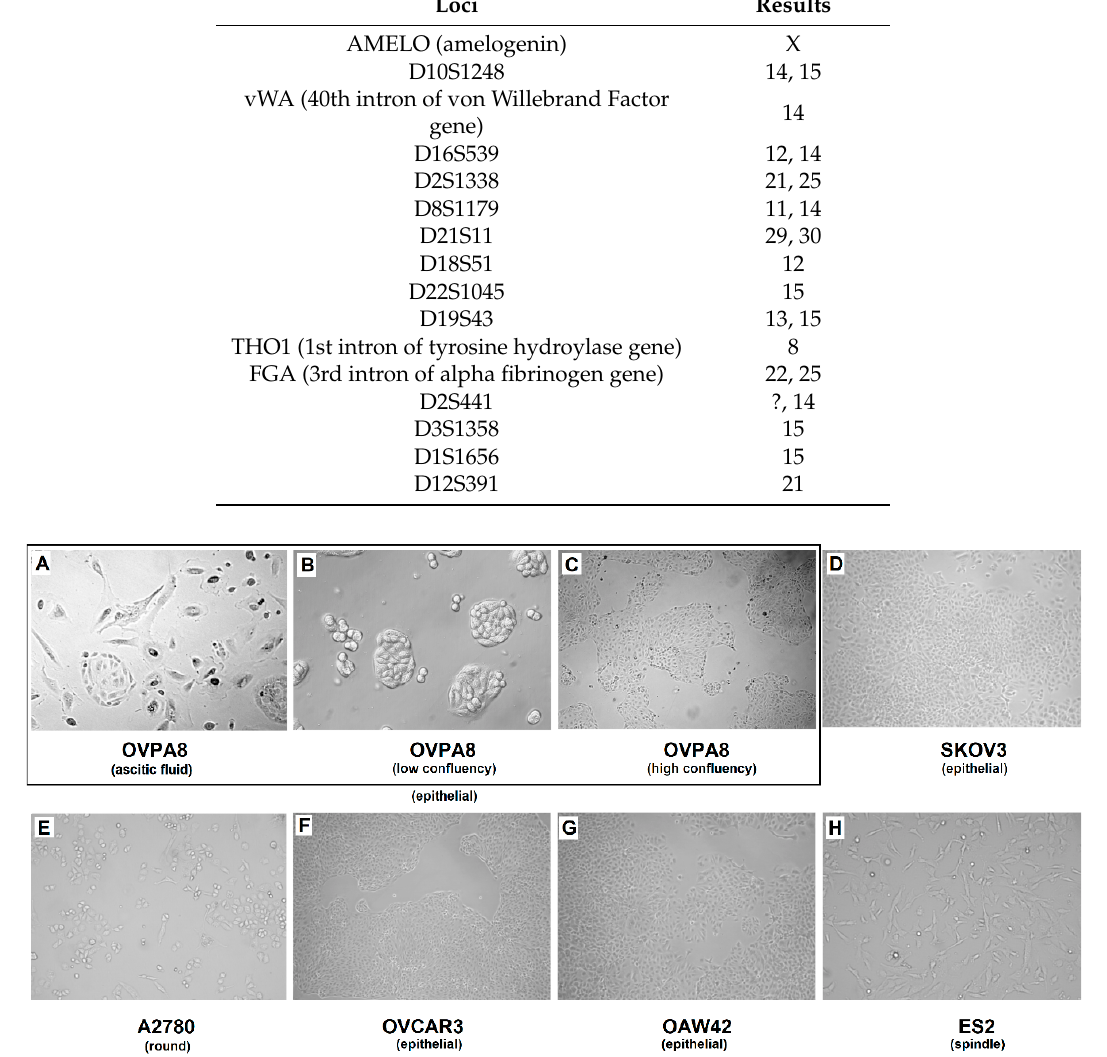
Figure 4. Cellular morphology of ovarian cancer cell lines (phase-contrast microscopy). OVPA8 ( A